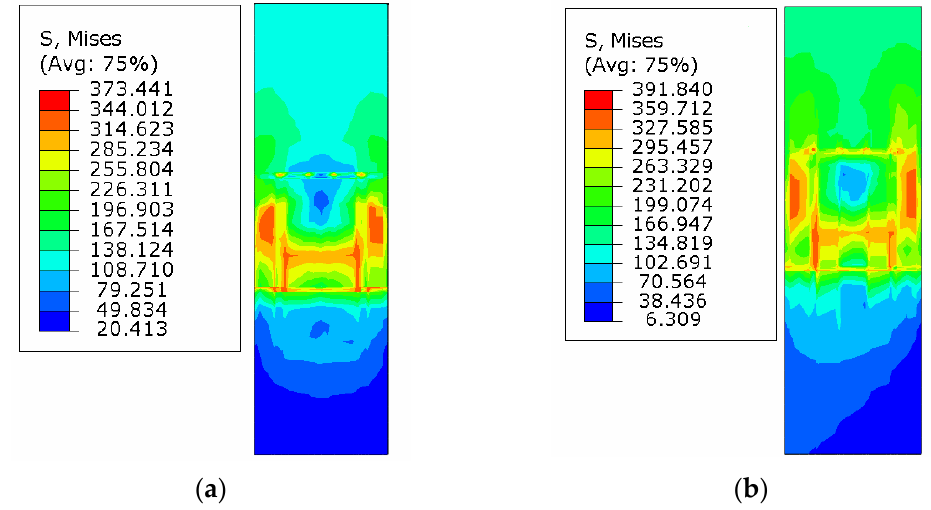
Figure 15. Von Mises stress contours of the right flange of steel tube in the connection zone: ( a ) RS connection; ( b ) RT connection.